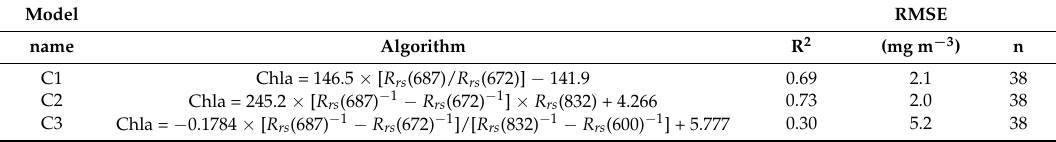
Table 5. The optimal chlorophyll a (Chla) algorithm using the C1, C2 and C3 models.